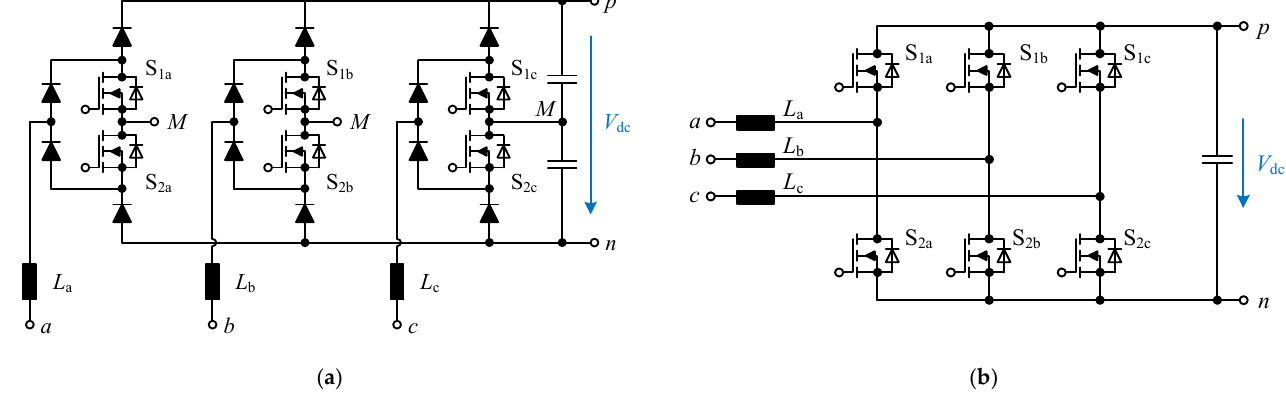
Figure 2. Considered topologies for the ac/dc stage: ( a ) V IENNA rectifier; ( b ) active six-switch boost-type (6S-Boost) PFC rectifier. Table 2. Characteristics of SiC MOSFETs used for comparison.